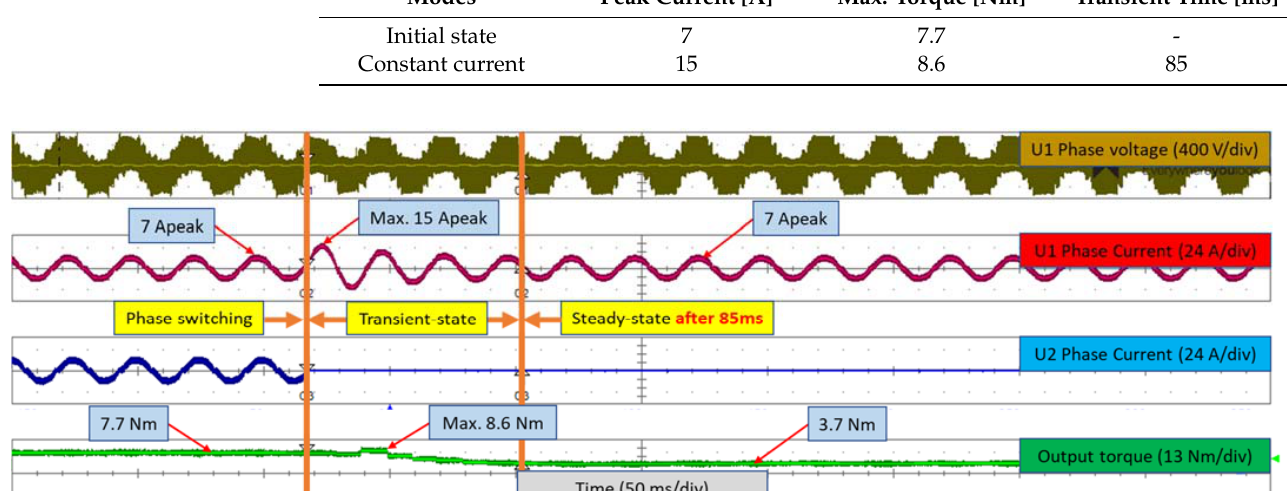
Figure 17. Transient state of constant-current mode at 480 r/min and 5 A. Table 11. Transient state of constant-current mode.